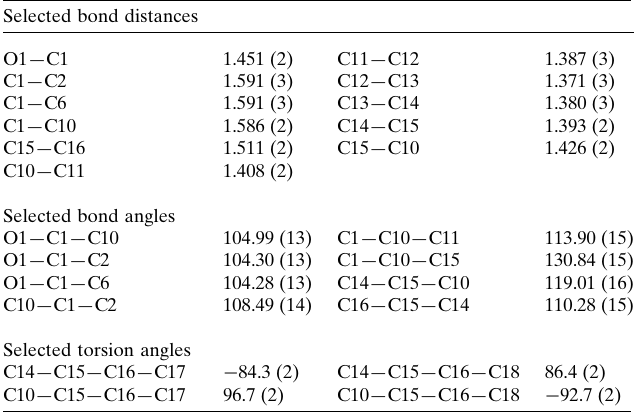
Table 1 Selected bond distances (A˚ ), angles, and torsion angles ( (cid:3) ) in the structure of H 2 [OO] tBu